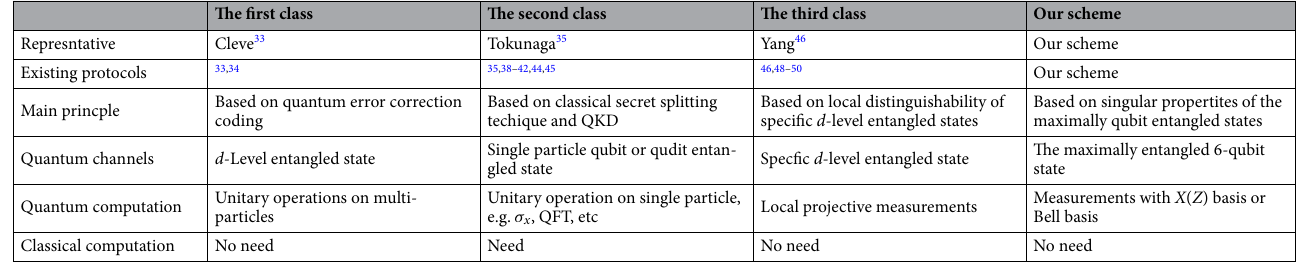
Table 5. A brief comparison of the various existing standard TQSS schemes sharing classical information (for convenience, we divide them into three classes) with our scheme.